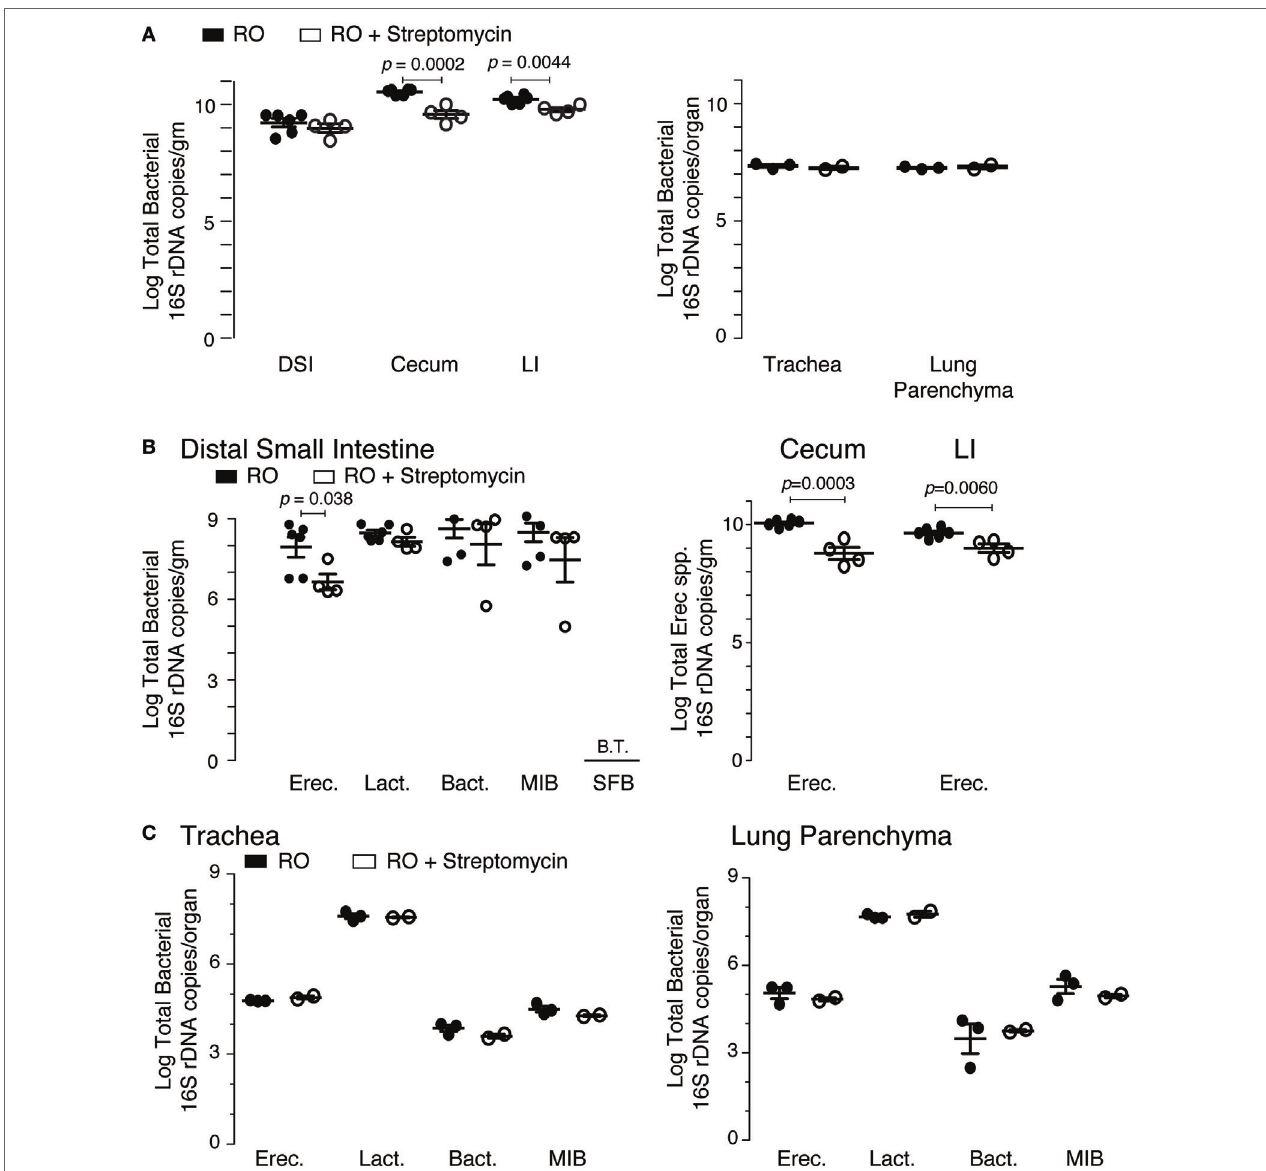
FigUre 3 | qPCR validation of streptomycin effect on intestinal and lung microbiota. (a) Total bacterial load (16S rDNA copies) in the intestinal and pulmonary compartments from mice exposed to 2 weeks of either reverse osmosis (RO) or RO + streptomycin water. Abbreviations: DSI, distal small intestine; LI, large intestine ( n = 4–6 mice/group/tissue location). (B) Specific bacterial groups identified in the distal small intestine (left panel) and Erec spp. in the cecum and LI (right panel) from mice treated as in panel (a) . (c) Specific bacterial groups identified in the trachea (left) and lung parenchyma (right) from mice treated as in panel (a) . Microbiota determined by 16S qPCR, with quantities expressed as log total bacterial species per gram of intestinal sample or log total bacterial species per lungs or trachea ( n = 2–6 mice/group/tissue location). Abbreviations: Erec, Eubacterium rectale/Clostridium coccoides , Lact, Lactobacillus , Bact, Bacteroides , MIB (S24-7), Mouse intestinal Bacteroides , SFB, Segmented filamentous bacteria , B.T., below